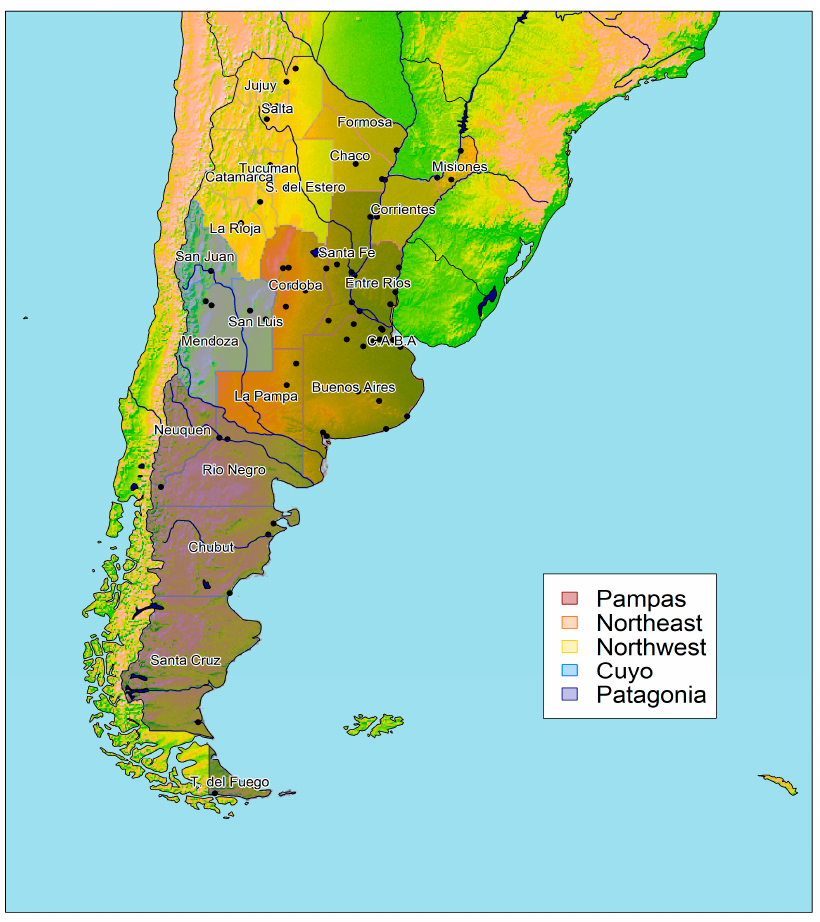
Figure A1. Description of the study area. Digital elevation model, provinces, location of cities with population greater than 50,000 inhabitants and regions used in this study.